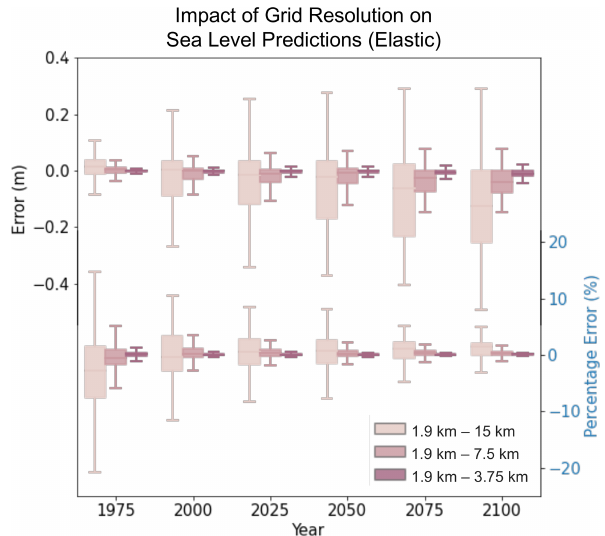
Figure 5. Evolution of error in elastic sea-level predictions due to grid resolution from 1950 to 2100 with the 1km input resolution ICE-RD ice model. Box–whisker plots of the error and percent er- ror (see methods) calculated from the difference in predicted sea- level changes from the start of the simulation to the indicated time within 10km of the grounding line at that time between a simulation with 1.9km resolution and simulations adopting 15km (light pink), 7.5km (medium pink) and 3.75km (dark pink) grid resolutions. The box represents (from bottom to top) the 25th percentile, median and 75th percentile of the distribution, whilst the whiskers repre- sent the “minimum” (25th percentile minus 1.5 times the interquar- tile range) and “maximum” (75th percentile plus 1.5 times the in- terquartile range). Error (m) is the difference between sea-level pre- dictions from the higher–lower resolution simulation. Percentage error (%) is calculated as 100 × (SL 1 . 9km − SL lowres )/ SL 1 . 9km for each grid